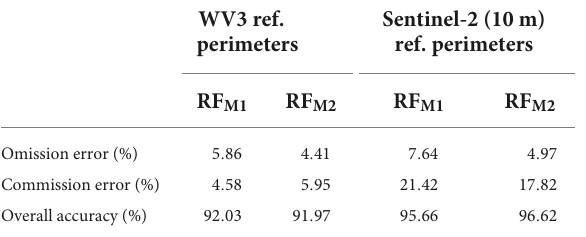
TABLE 4 Accuracy analysis results obtained at 1.2 m spatial resolution from the WV3 images and 10 m resolution from the Sentinel-2 reference